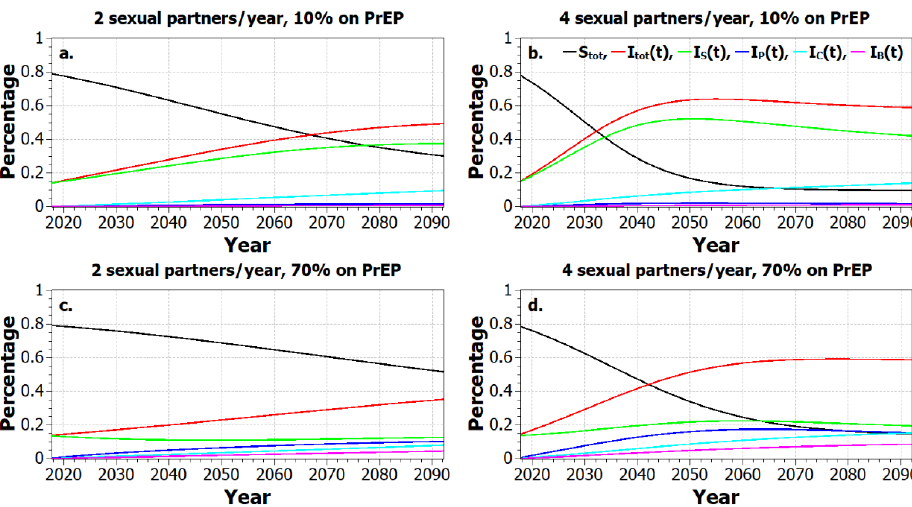
Figure 4. The pessimistic scenario implies inconsistent PrEP usage. These graphs show the total susceptible (black line) and infected (red line) percentages as a function of time. In addition, the breakdown into the detailed makeup of each category is presented with the legend as shown in ( b ), where 𝑆 𝑡𝑜𝑡 is the total number of susceptibles, 𝐼 𝑡𝑜𝑡 is the total infected, 𝐼 𝑆 is the portion of 𝐼 𝑡𝑜𝑡 using no prophylaxis, 𝐼 𝑃 is the portion of 𝐼 𝑡𝑜𝑡 using only PrEP, 𝐼 𝐶 is the portion of 𝐼 𝑡𝑜𝑡 using only condoms, and 𝐼 𝐵 is the portion of 𝐼 𝑡𝑜𝑡 using both PrEP and condoms. ( a ) Projection when 10% of the population is using PrEP and the average number of sexual partners is two. ( b ) Projection when